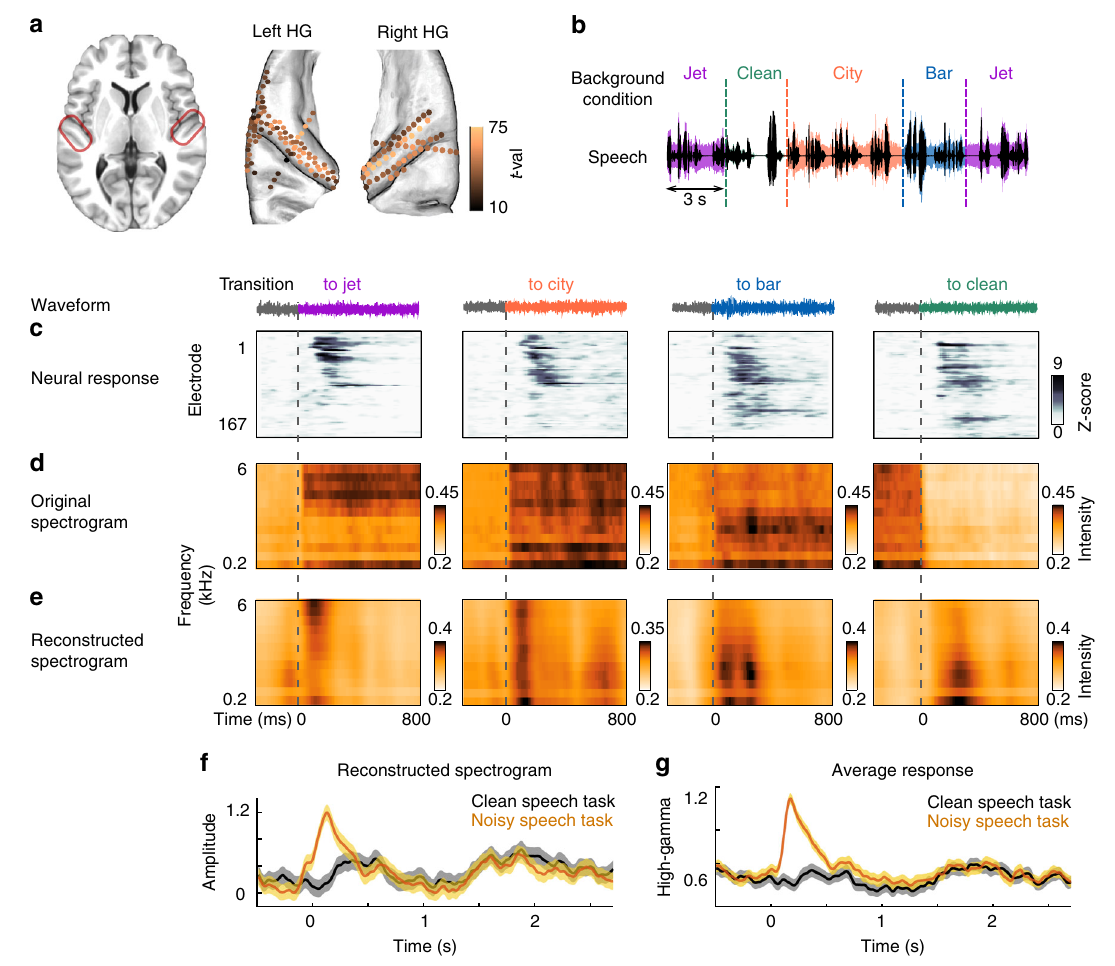
Fig. 1 Neural adaptation in transition to a new background condition. a Electrodes with signi fi cant response to speech (t-val > 10, t -test speech versus silence), located in Heschl ’ s gyrus, the superior temporal gyrus, the transverse temporale sulcus and the planum temporale, shown on a BCI-DNI brain atlas. b Experiment design. Clean speech is shown with black; colors show the different background conditions, which change randomly between bar, city, jet, and clean (no noise) every 3 or 6s. c The average normalized neural responses aligned by the time of transition (dashed lines) to each background condition (columns). Electrodes are sorted based on the similarity of their adaptation strength using Unweighted Pair Group Method with Arithmetic Mean (UPGMA) algorithm. d , e Average original spectrograms and reconstructed spectrograms from the neural responses over all transitions to each of the four background conditions. The spectrograms are aligned by the time of transitions. f The reconstructed spectrograms averaged over the frequency dimension are shown for clean speech task and noisy speech task. The reconstruction from noisy speech is the average of all three noisy conditions. Shaded error bars indicate standard error. g Direct comparison of neural responses to noisy speech task and clean speech task normalized based on the responses in the silence interval. Shaded error bars indicate standard